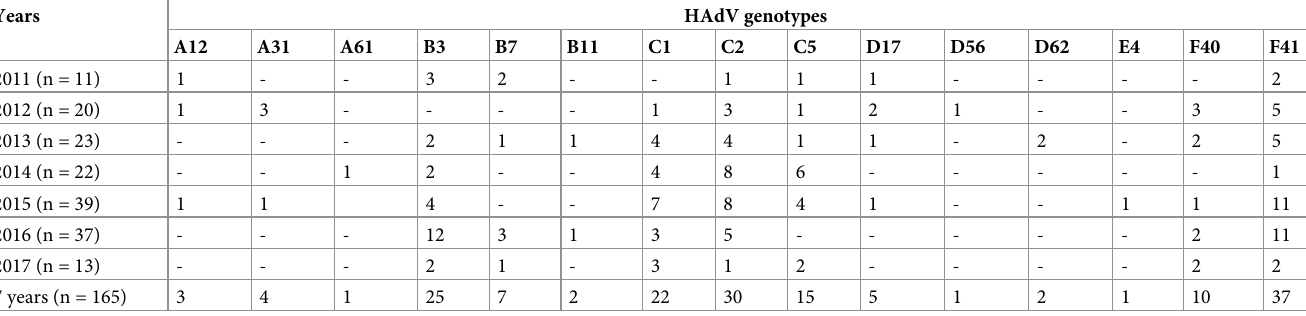
https://doi.org/10.1371/journal.pone.0220263.t002